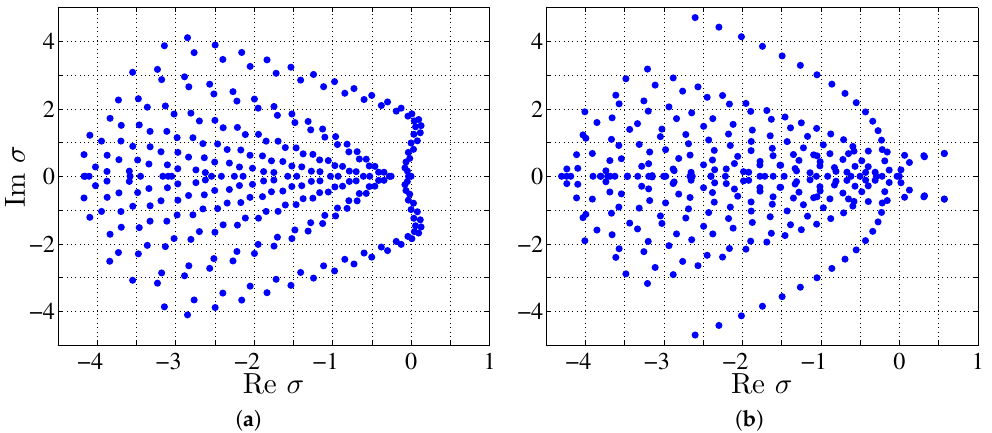
Figure 10. The leading eigenvalues, σ = λ / Ra , at Ra = 500, L s = 2 and β = 0. ( a ) φ = 0 ◦ ; ( b ) φ = 20 ◦ . All of the unstable modes for both the horizontal and inclined cases exhibit a similar structure as that of the corresponding fastest-growing mode in Figure